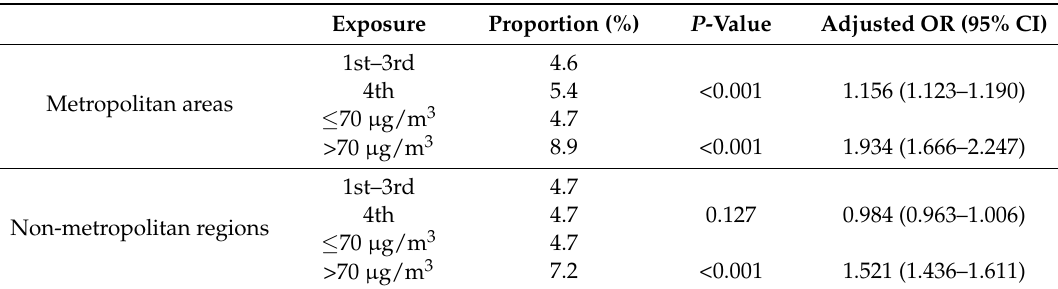
Table 4. Associations of preterm births and maternal exposure to particulate matter less than 10 µ m (PM 10 ) during pregnancy according to the residential